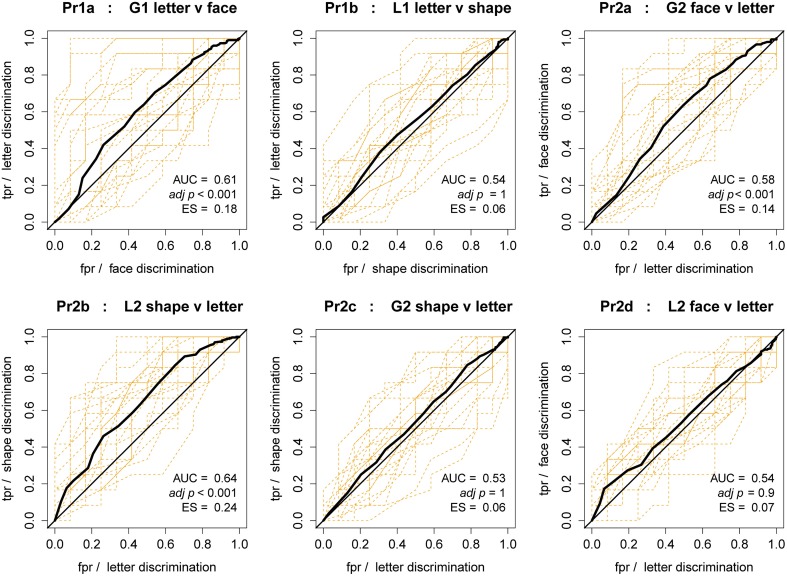
ROC curves for discrimination score classification of stimulus condition. Each figure corresponds to a hypothesis, and shows average curve as a thick black line, random chance level as a diagonal line, and curves per participant as dashed lines. Legend shows AUC (area under curve), significance of AUC (Bonferroni-Holm adjusted), and ES (effect size) of AUC in bottom right.